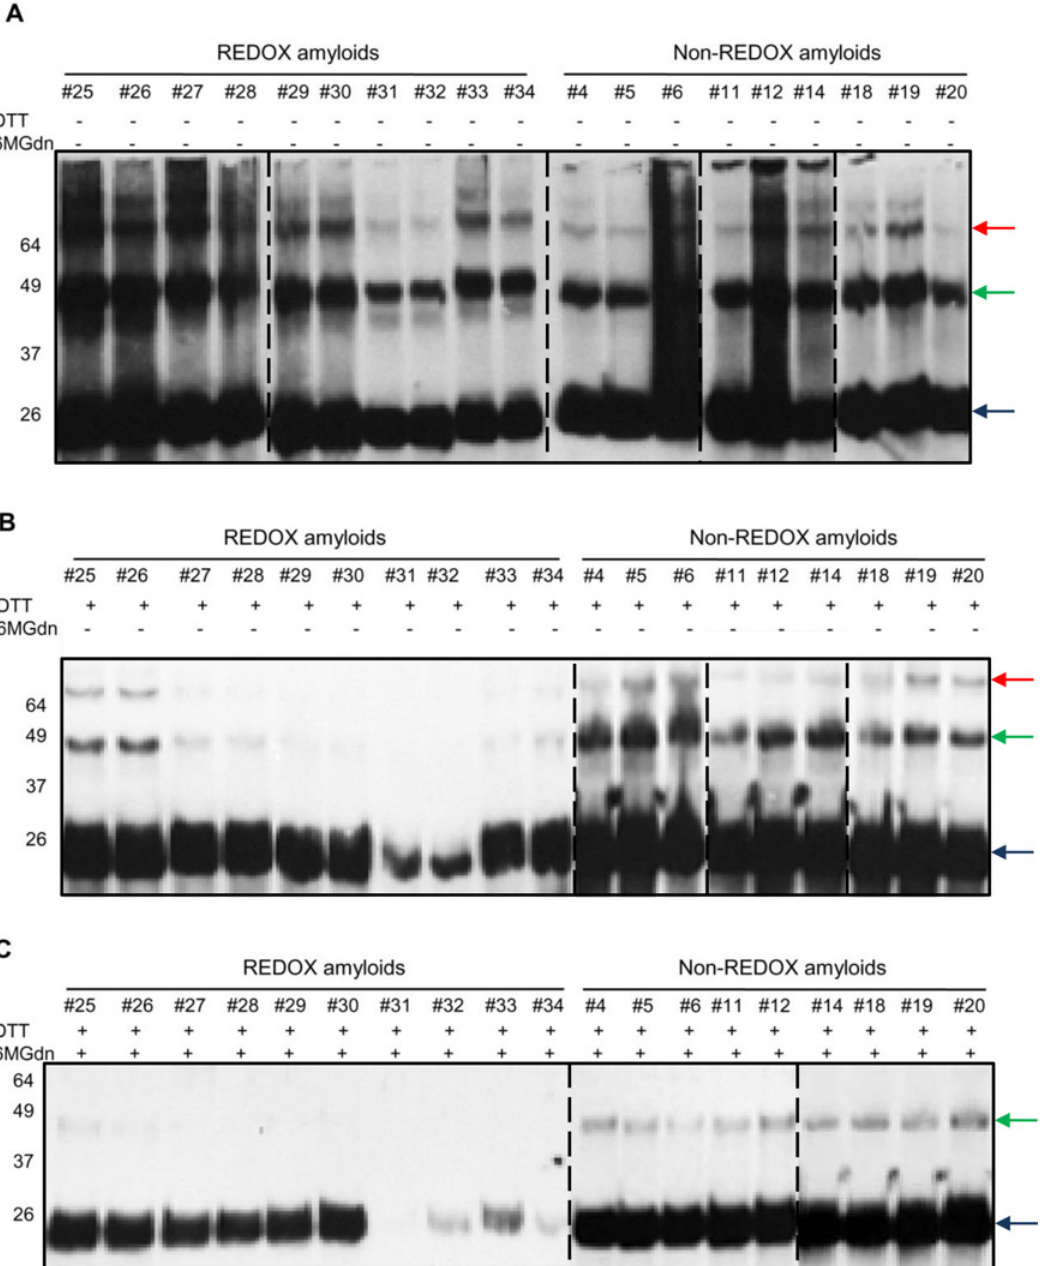
Fig 3. Western blot analysis of amyloid fibrils performed under reducing and non-reducing SDS-PAGE. Monomeric (indicated by blue arrow) recMoPrP(23 – 231) was converted into amyloid forms by intermolecular disulfide linkage following the REDOX process. Western blotting of non-reducing Sodium Dodecyl Sulphate — PolyAcrylamide Gel Electrophoresis (SDS-PAGE) showing the conversion of recMoPrP(23 – 231) to amyloids is indicated by dimer (green arrow), trimer (red arrow), and more complex structures in both processes (A). Western blotting of reducing SDS-PAGE after treatment of amyloid with Dithiothreitol reducing agent (DTT) shows the decrease in signals of dimer, trimer and more complicated structures in all lanes of amyloid samples from REDOX-process (B). Western blotting of reducing SDS-PAGE of amyloid after a 3-day treatment with denaturant (6M Gdn-HCl), and subsequently with reducing agent DTT shows only monomeric recMoPrP(23 – 231) bands and the disappearance of more complicated structures in all lanes of amyloid samples in REDOX process (C). Western blots were performed using Fab D18 monoclonal antibody (1 μ g/mL). Blots were developed with the enhanced chemiluminescent system (ECL, Amersham Biosciences) and visualized on Hyperfilm (Amersham Biosciences)